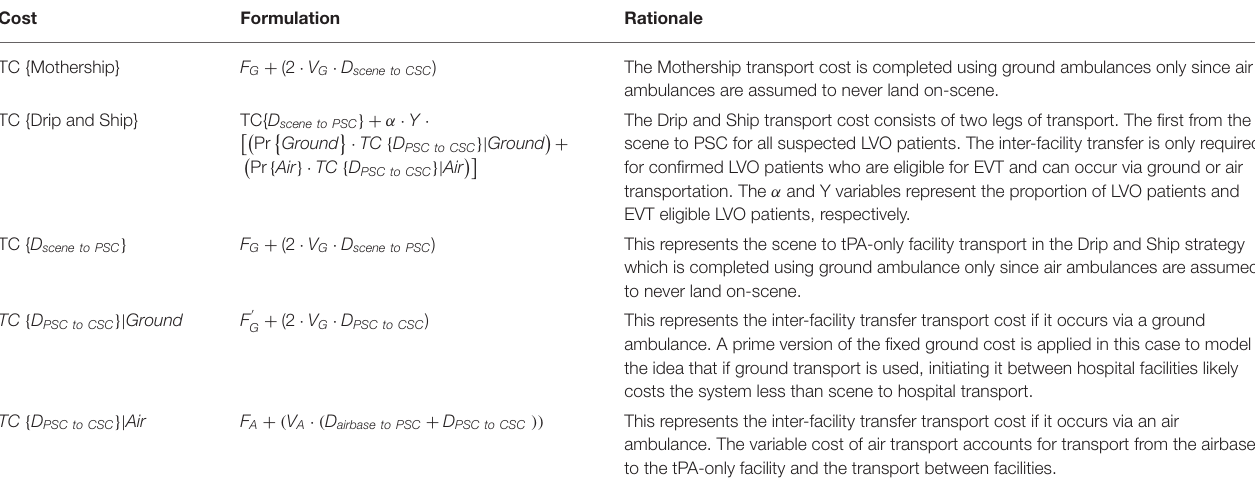
TABLE 2 | Formulation for determining transport cost using both the Drip-and-Ship and Mothership transport